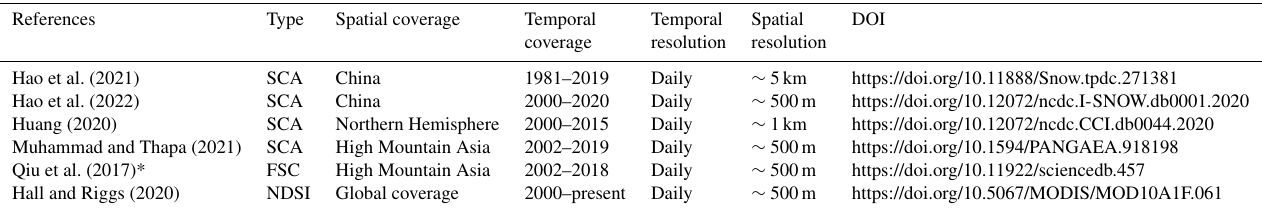
Table 1. Typical long-term cloud-free snow cover products covering most snow-dominated regions in China.